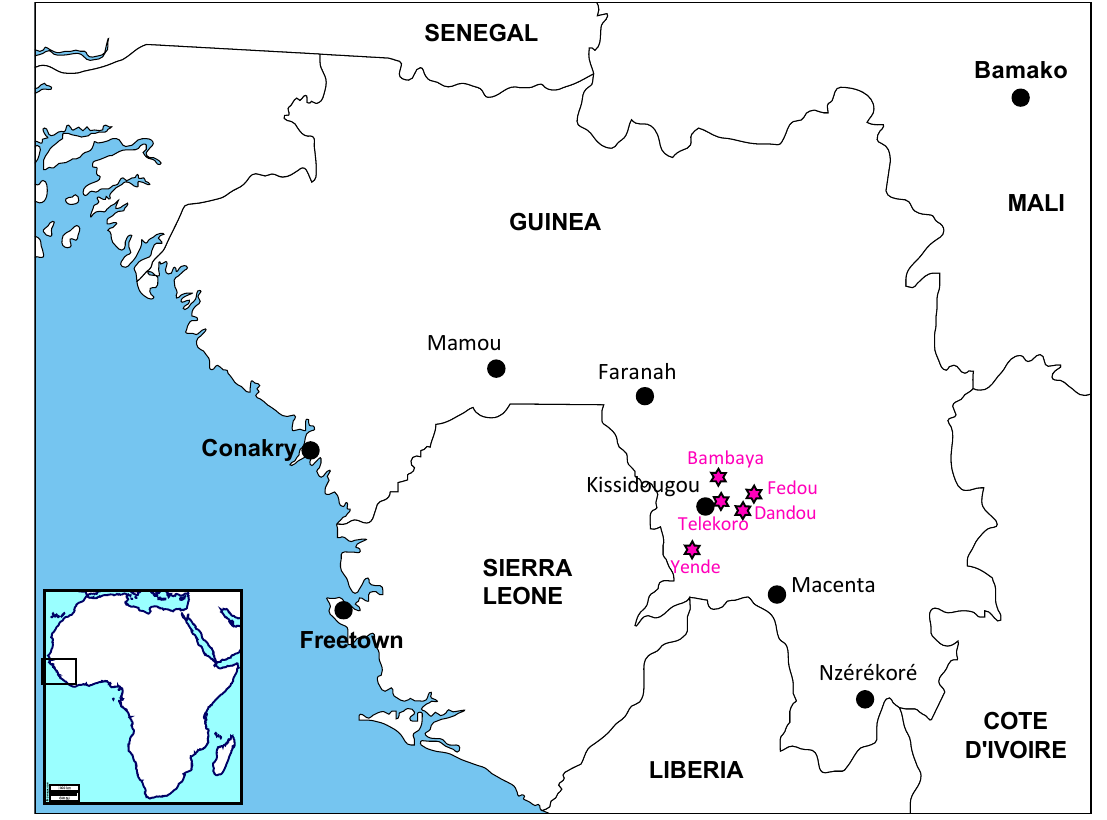
Figure 1. Map of Guinea showing the towns of interest, Kissidougou where the patient lived and Mamou where he died. Faranah, Macenta and Nzérékoré are the towns where Lassa virus sequences obtained from humans have been documented. The pink stars represent the locations of Lassa fever cases described in Henderson et al. 1972 [17], Bausch et al. 2001 [12] and this study.